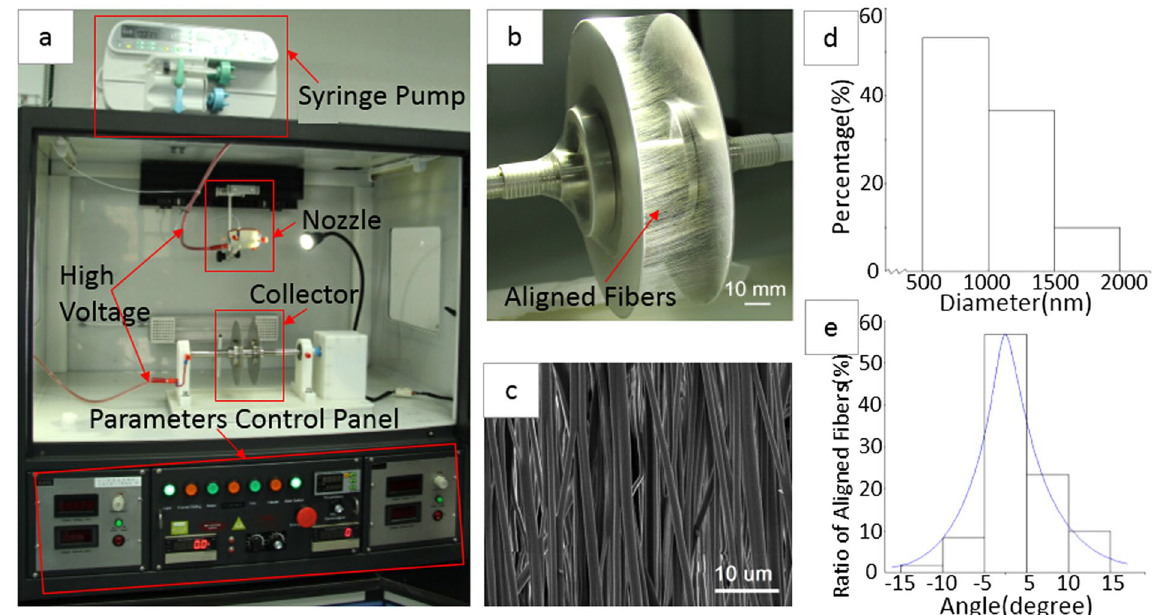
Figure 2. Electrospinning device and PLGA nanofibrous scaffold: ( a ) the main component of the device; ( b ) aligned fibers deposited between two parallel, thin plates; ( c ) an SEM image of a PLGA scaffold; ( d ) a histogram of fiber diameter; and ( e ) a histogram of fiber alignment.